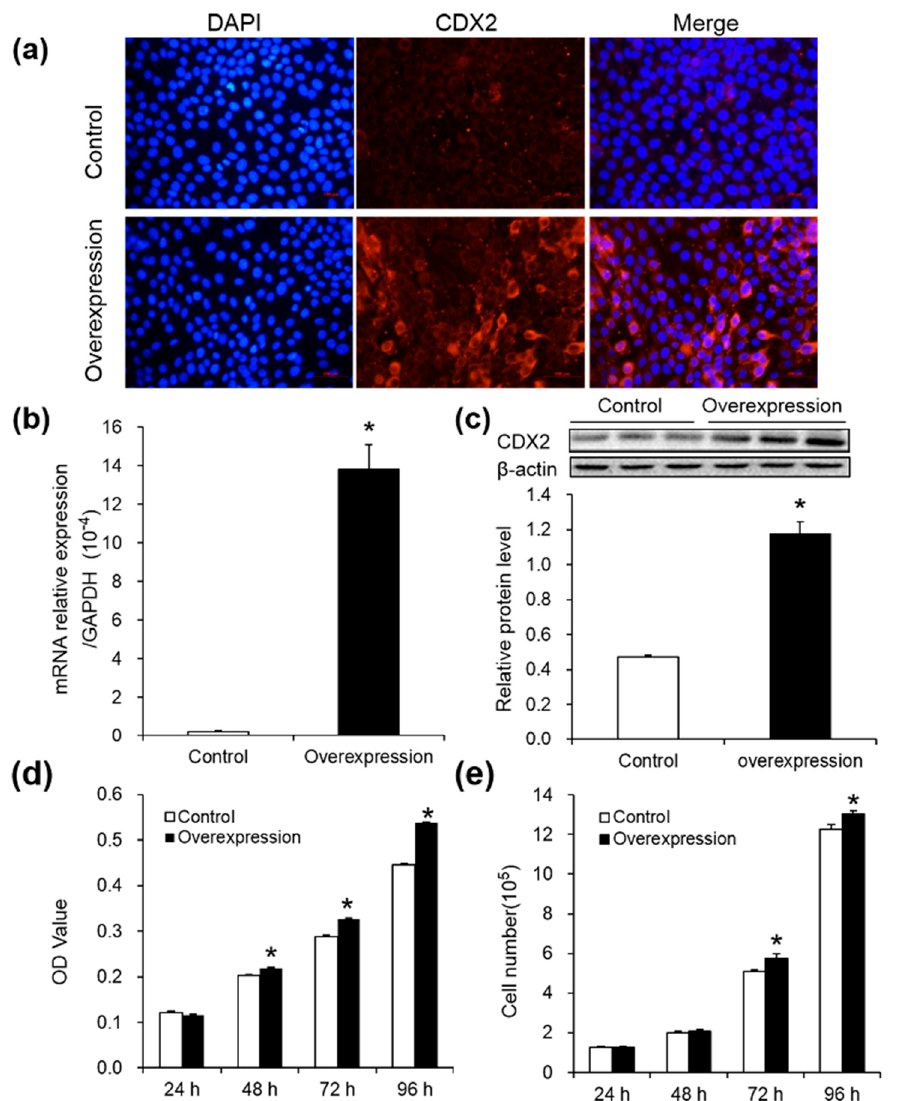
Figure 1. Caudal type homeobox 2 (CDX2) overexpressed in IPEC-J2 cells and increased cell proliferation. ( a ) Representative immunofluorescence images of control and overexpression groups 48 h after seeding, labeled with DAPI (blue) and CDX2 antibody (red) (200×). Scale bar: 100 μ m. ( b,c ) CDX2 mRNA abundance ( n = 6) and protein expression ( n = 3) in the control and overexpression group. AU: arbitrary unit; ( d,e ) the OD value and cell number were assessed by MTT assay ( n = 20) and cell counting ( n = 6), respectively. Control: control group; Overexpression: CDX2 overexpression group. Representative results of three independent experiments are shown as the mean ± SEM; * p < 0.05.